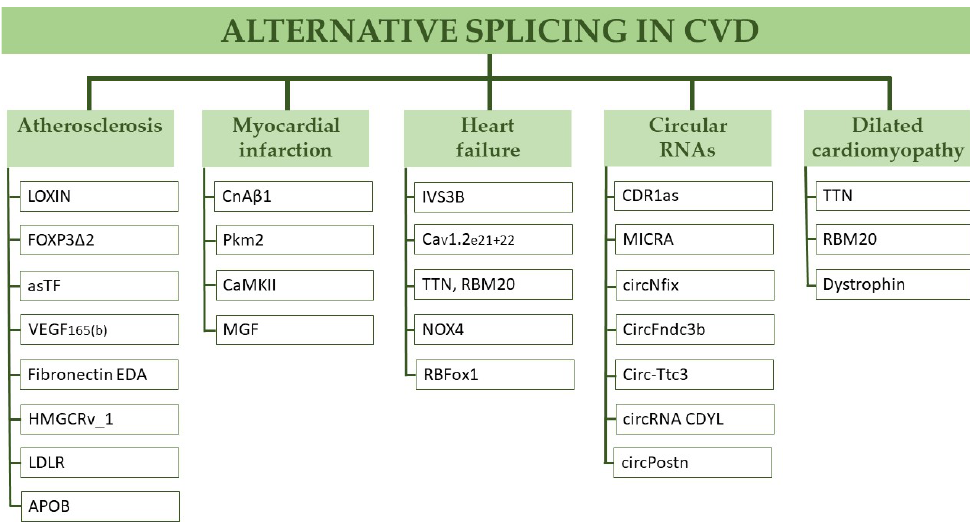
Figure 2. A graphic illustration of the topics mentioned in this review. Abbreviations: CVD—cardiovascular disease. The individual abbreviations are defined upon the first mention of the expression in the main text.